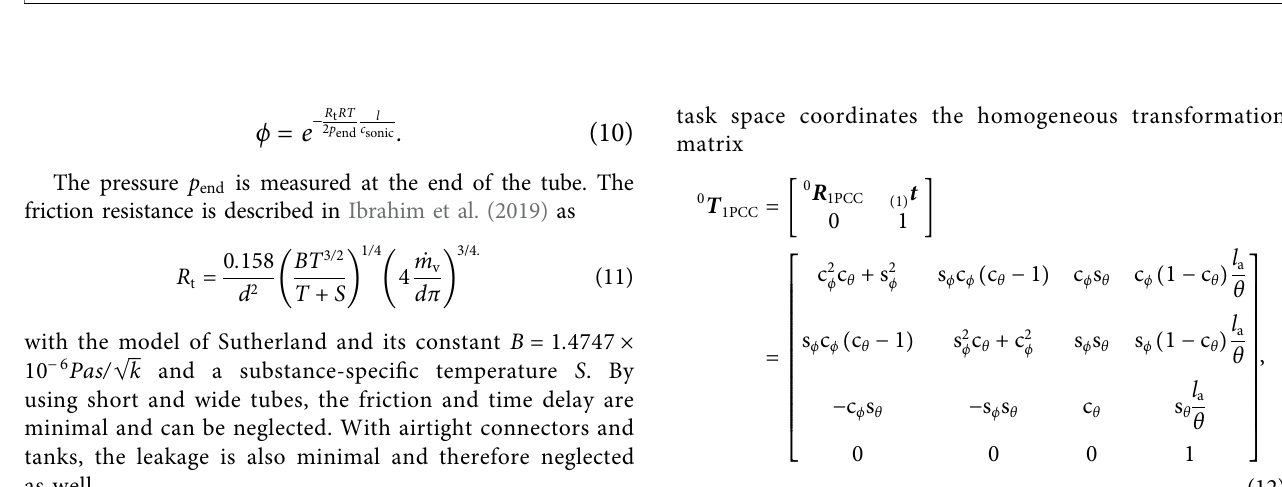
FIGURE 2 | Geometry of soft pneumatic actuator with PCC parameters ϕ , θ , l, top view (A) , side view (B) and coordinate frames used for the reconstruction model (C) .